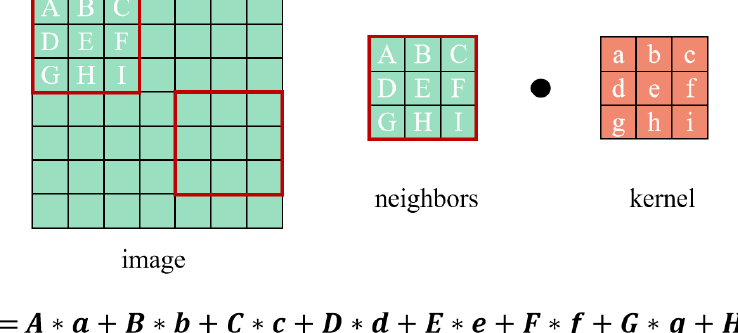
Figure 2. Convolution of an image: The upper panel shows the neighbors and the convolution kernel size on the image. The red box is the convolution range, the black solid is the convolution operation. The bottom formula describes the method of computation for the discrete convolution of the image.